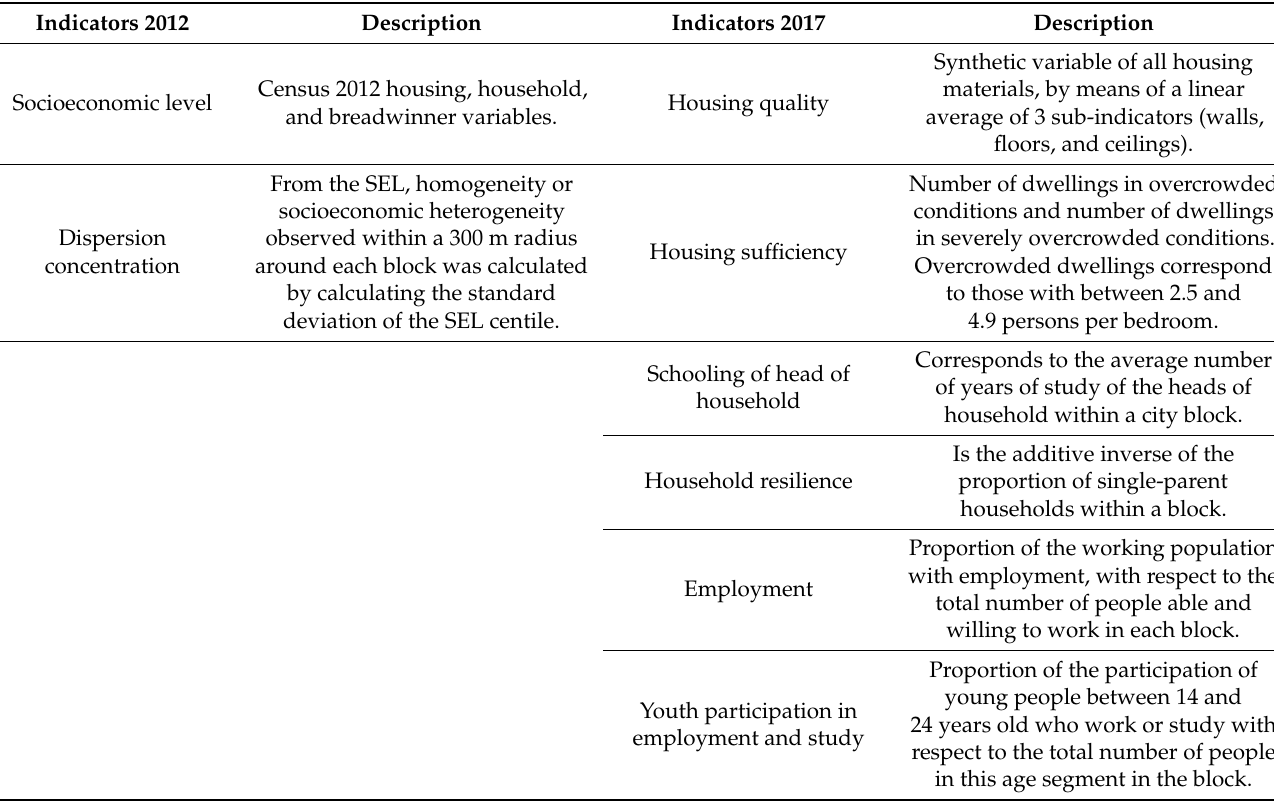
Table 1. Indicators and variables considered for calculating the socioeconomic dimension. Indicators 2012 Description Indicators 2017 Description